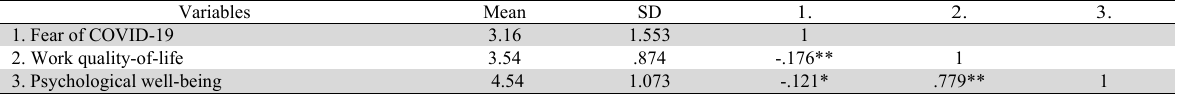
Pearson’s r Correlations between the Fear of COVID-19, Work Quality-of-Life and Psychological Well-Being (n = 339) Variables